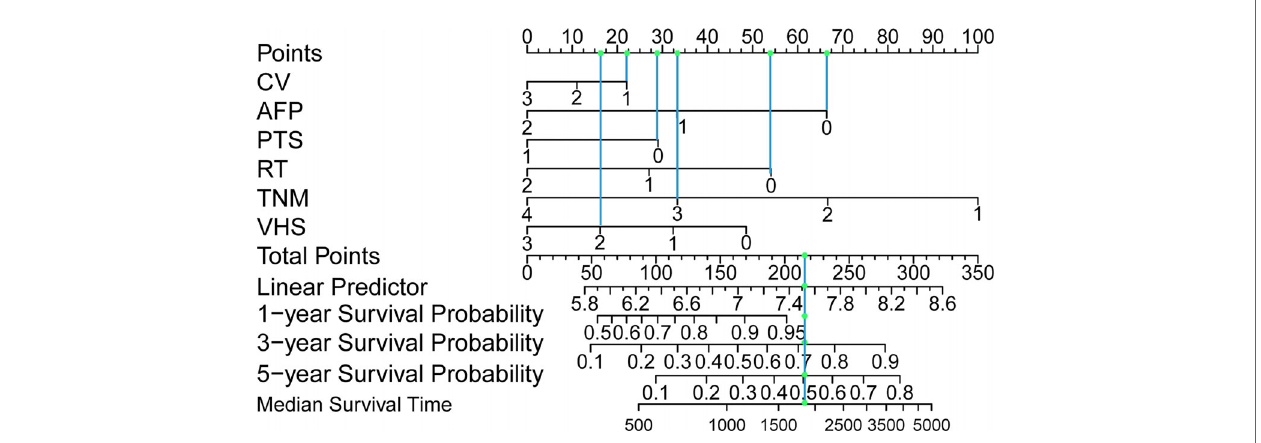
FIGURE 2 | Postoperative hepatocellular carcinoma prognostic nomogram. (To use the nomogram, a patient ’ s values are located on each variable axis, and a line is drawn upward to determine the number of points received for each variable value. The sum of these numbers is located on the total point axis, and a line is drawn downward to the survival axes to determine the probability of survival at 1, 3 and 5 years and the median survival time.). CV, creatinine value; AFP, alpha-fetoprotein; PTS, patients Tumor status; RT, resection marginal residual tumor; TNM, tumor node metastasis; VHS, viral hepatitis serology.